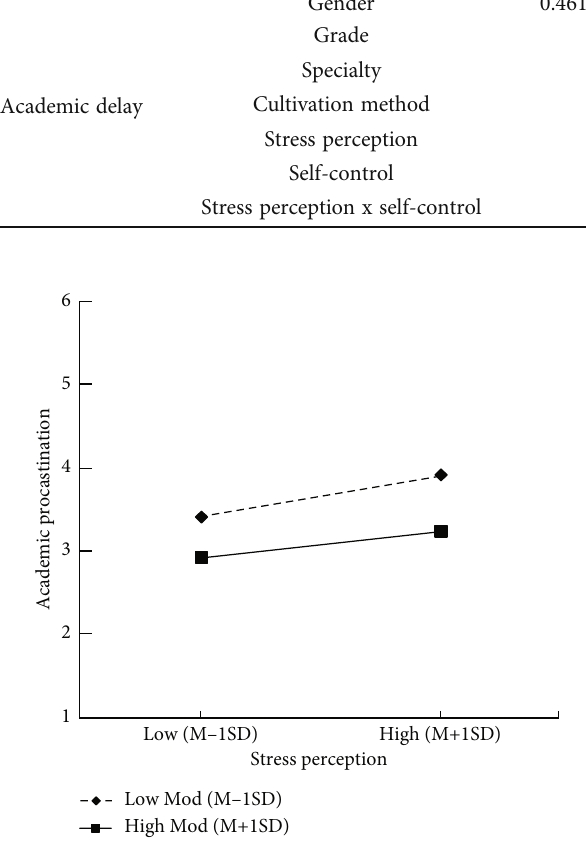
Figure 3: The moderating e ff ect of self-control on stress perception and academic